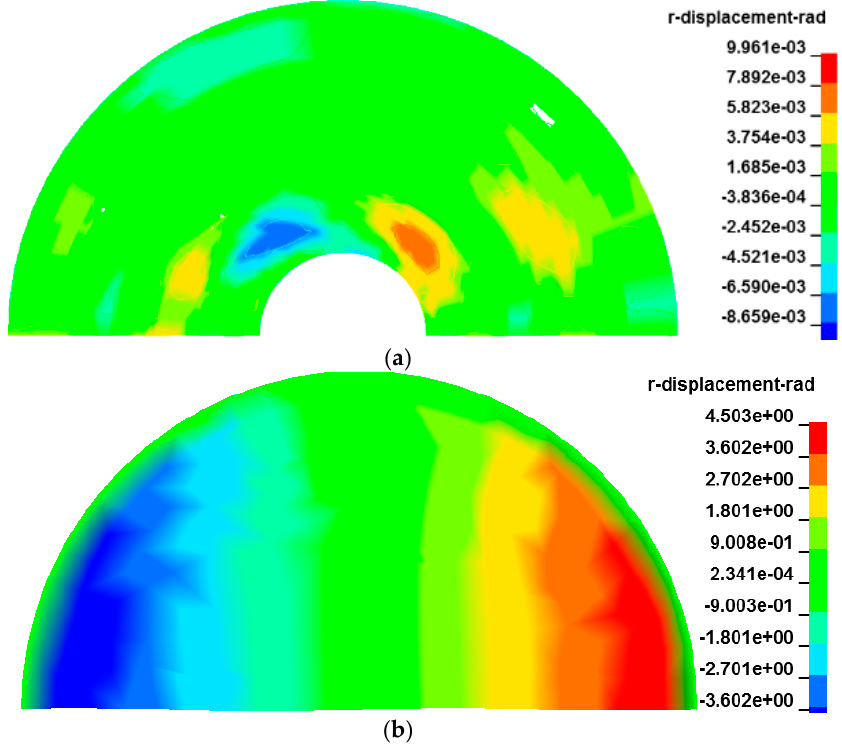
Figure 21. The velocity counter of air part with thickness 0.01 m, P22, when t = 1.20 s. ( a ) Air part outside. ( b ) Air part inside.